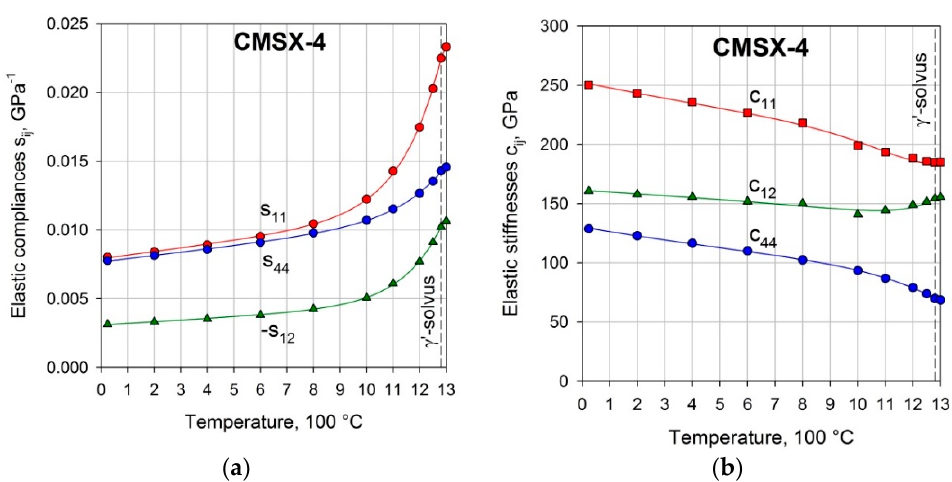
Figure 6. Elastic constants of superalloy CMSX-4 as functions of temperature. ( a ) Elastic compliances s ij and ( b ) elastic stiffnesses c ij . Symbols indicate the measured values, and the lines indicate the curves fitted with Equation (11).